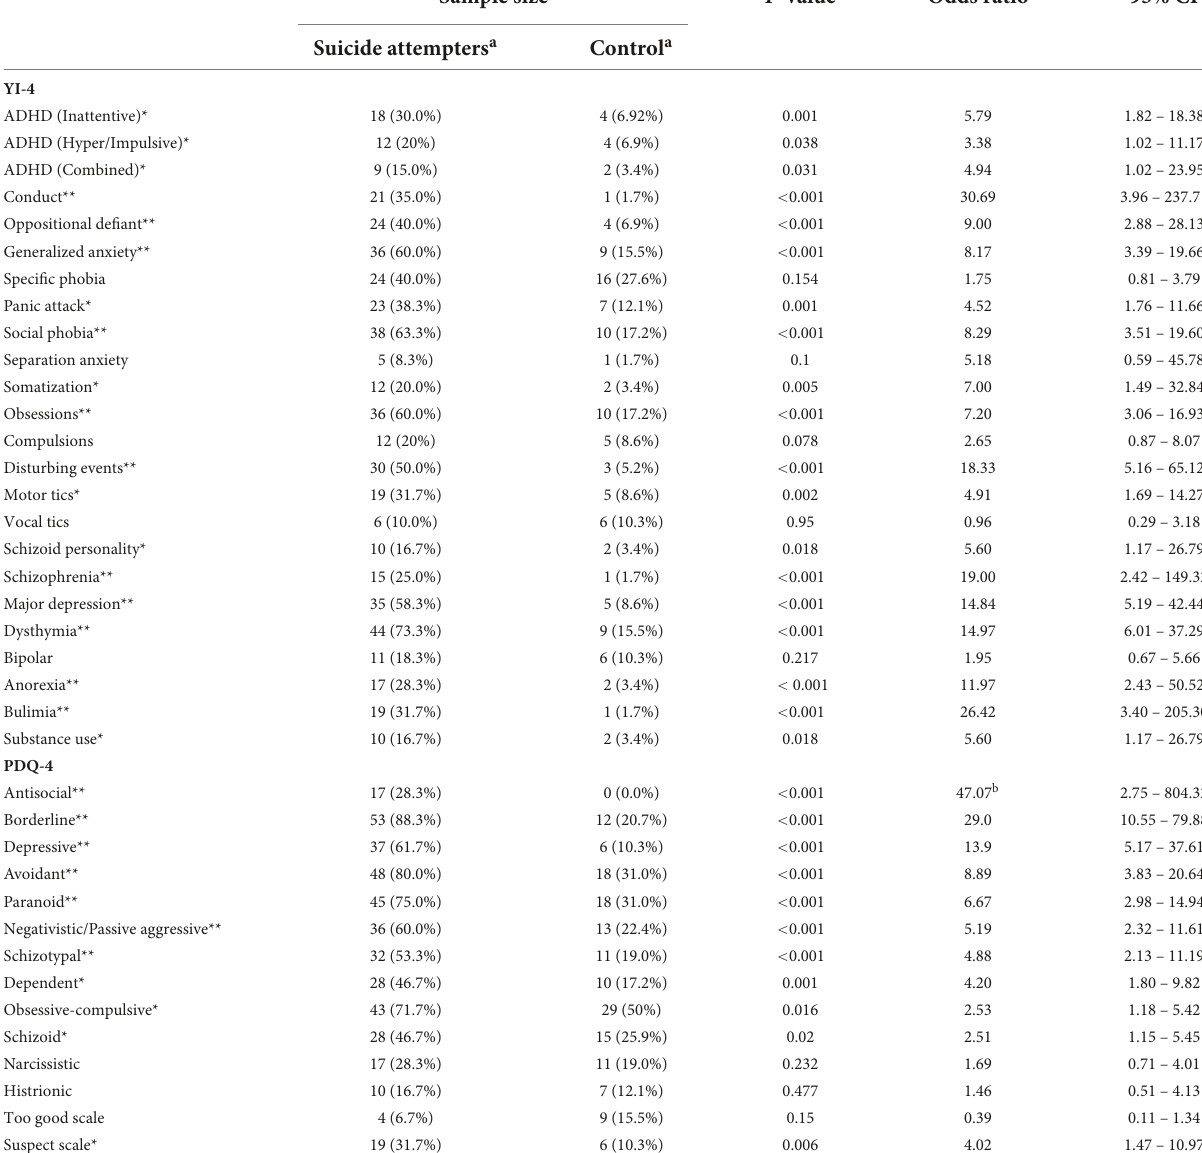
TABLE 6 Comparison of Axis I and II disorder traits between suicide attempters and control